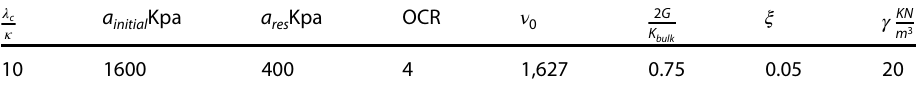
Table 2 Deterministic parameters of the soil